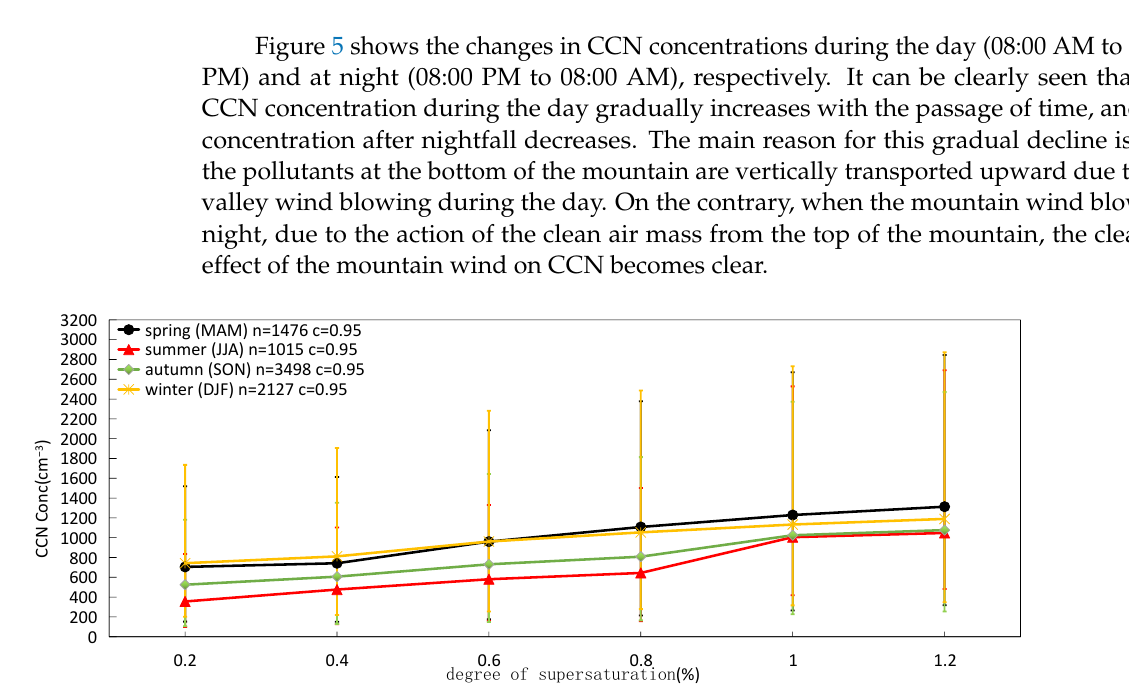
Figure 4. The diurnal variation in CCN in LPS.